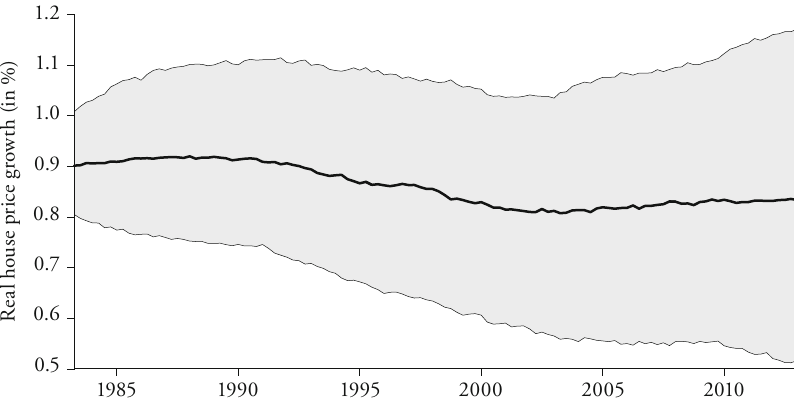
Figure 9: Peak Effect (after 5 Quarters) of House Price Responses to a Shock on the Mortgage Rate Change (i. e. User